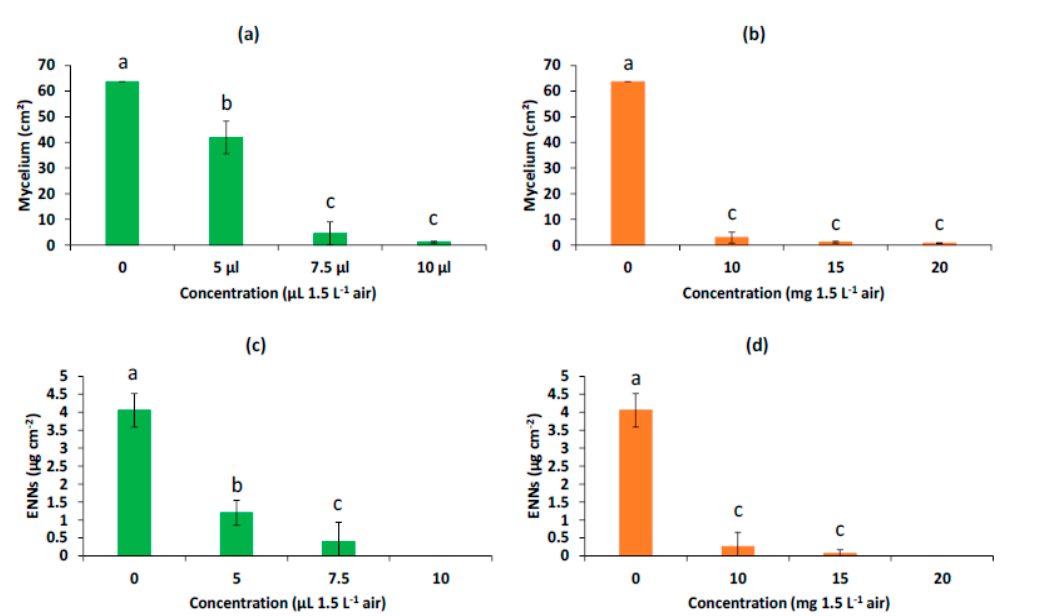
Figure 10. E ff ects of the volatile compounds released from AP-EO and AP-EO/MSPs on the mycelial growth of F. avenaceum incubated for 10 days at 25 °C.